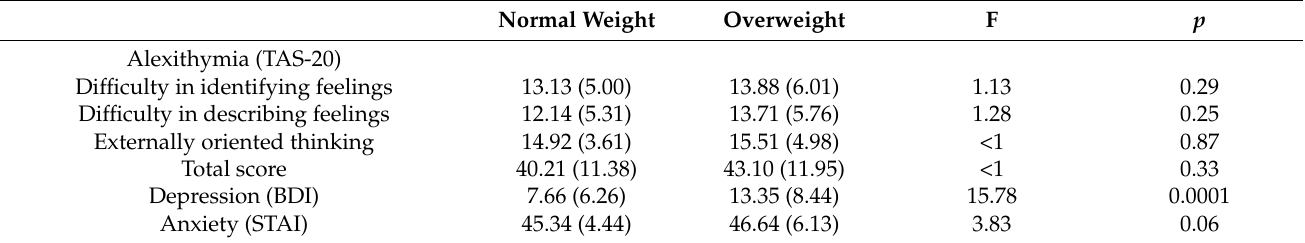
Table 3. Mean and standard deviation of the psychological dimensions in normal weight and overweight groups.